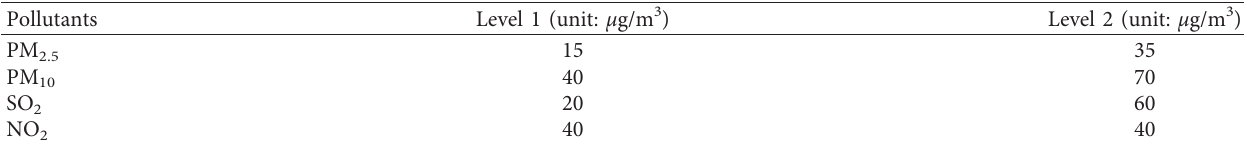
2.5 , PM 10 , SO 2 , and NO 2 .